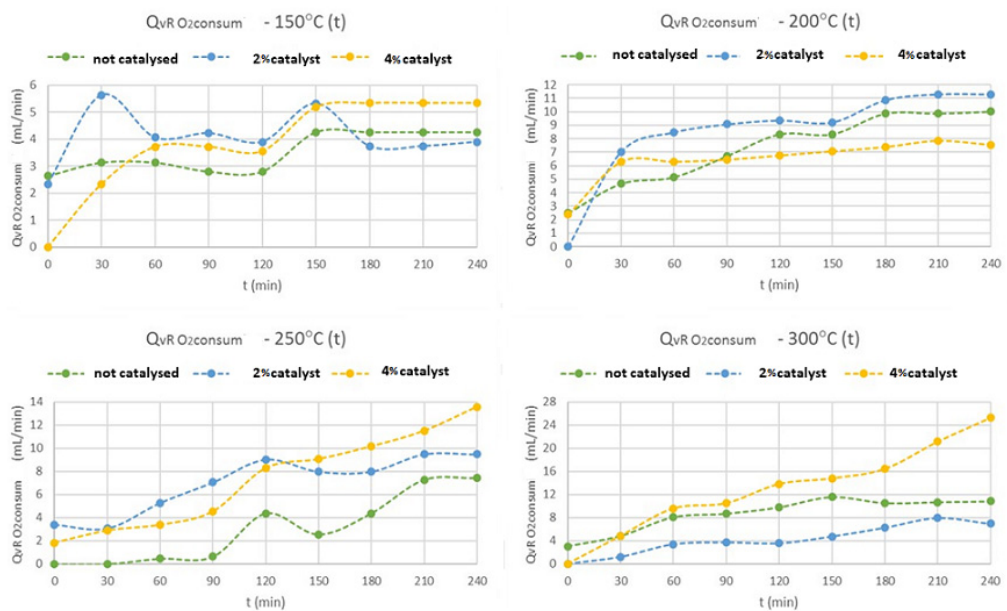
Figure 7. Comparison of the behavior of the volumetric flow rate of oxygen consumed over the test time for the synthesis gas production tests for di ff erent amounts of catalyst and temperatures (average values).